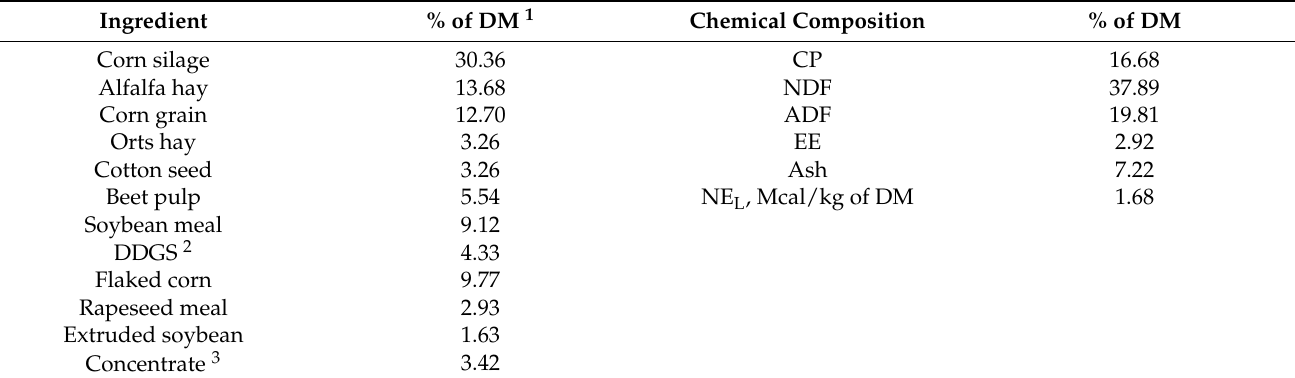
Table 1. Ingredient and nutrient composition of total mixed ration